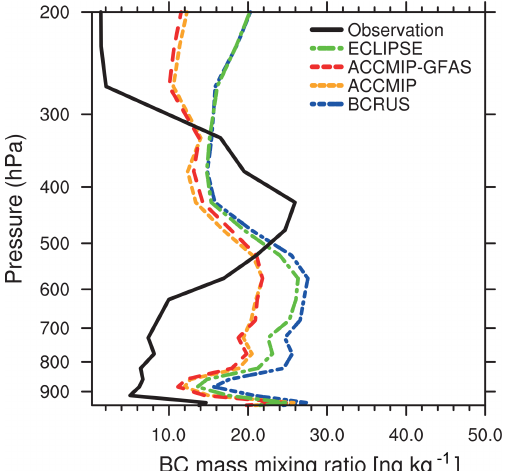
Figure 13. As in Fig. 10, but for the fall campaign HIPPO-2 in November 2009.